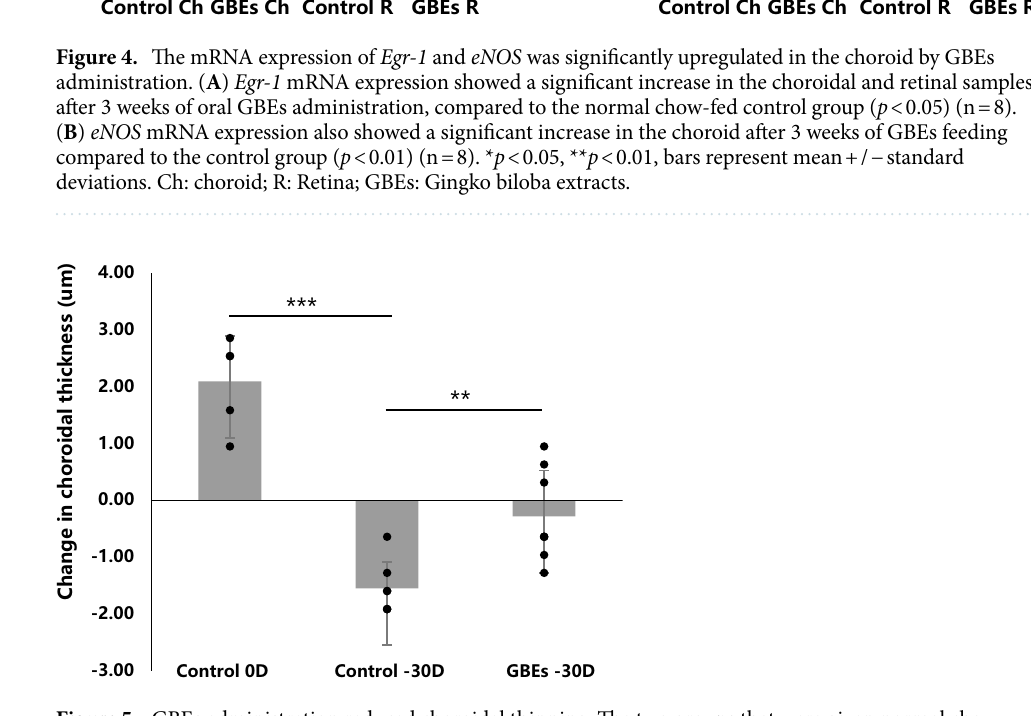
Figure 5. GBEs administration reduced choroidal thinning. The two groups that were given normal chow showed a significant difference in choroidal thickness between the − 30 D lenses group and the 0 D lenses group ( p < 0.001). Mice given GBEs chow with − 30 D lenses showed a statistically significant increase in choroidal thickness compared to the normal chow group with − 30 D lenses ( p < 0.01) (n = 6). ** p < 0.01, *** p < 0.001, Bars represent mean + / − standard deviations. The one-way ANOVA was used for statistical analysis. Control 0 D: mice fed with normal chow with 0 D lenses in both eyes; control − 30 D: mice fed with normal chow with − 30 D lenses in both eyes; GBEs − 30 D: mice fed with GBEs with − 30 D lenses in both